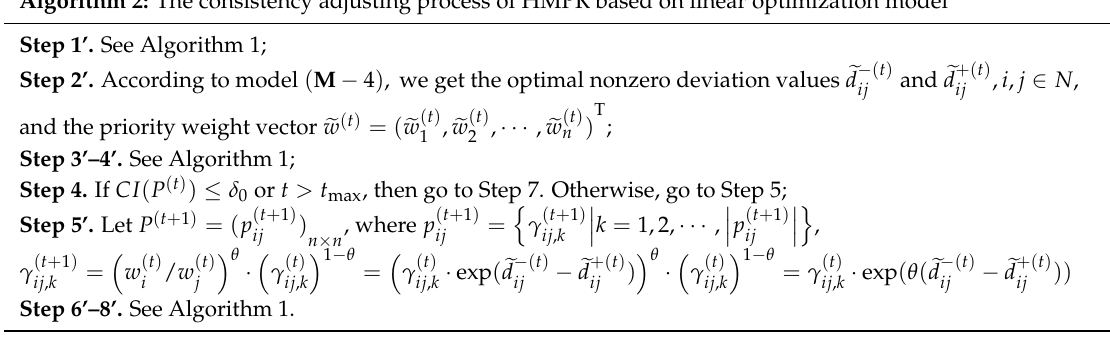
Algorithm 2: The consistency adjusting process of HMPR based on linear optimization model